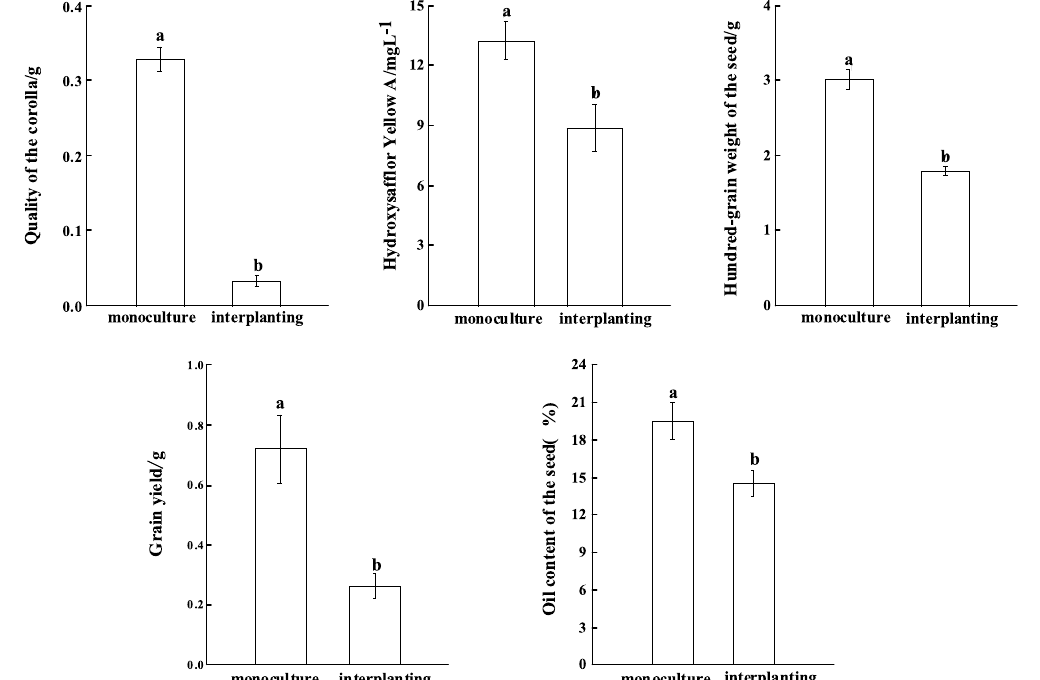
Figure 3. Yield and quality of the economic organs of Carthamus tinctorius.